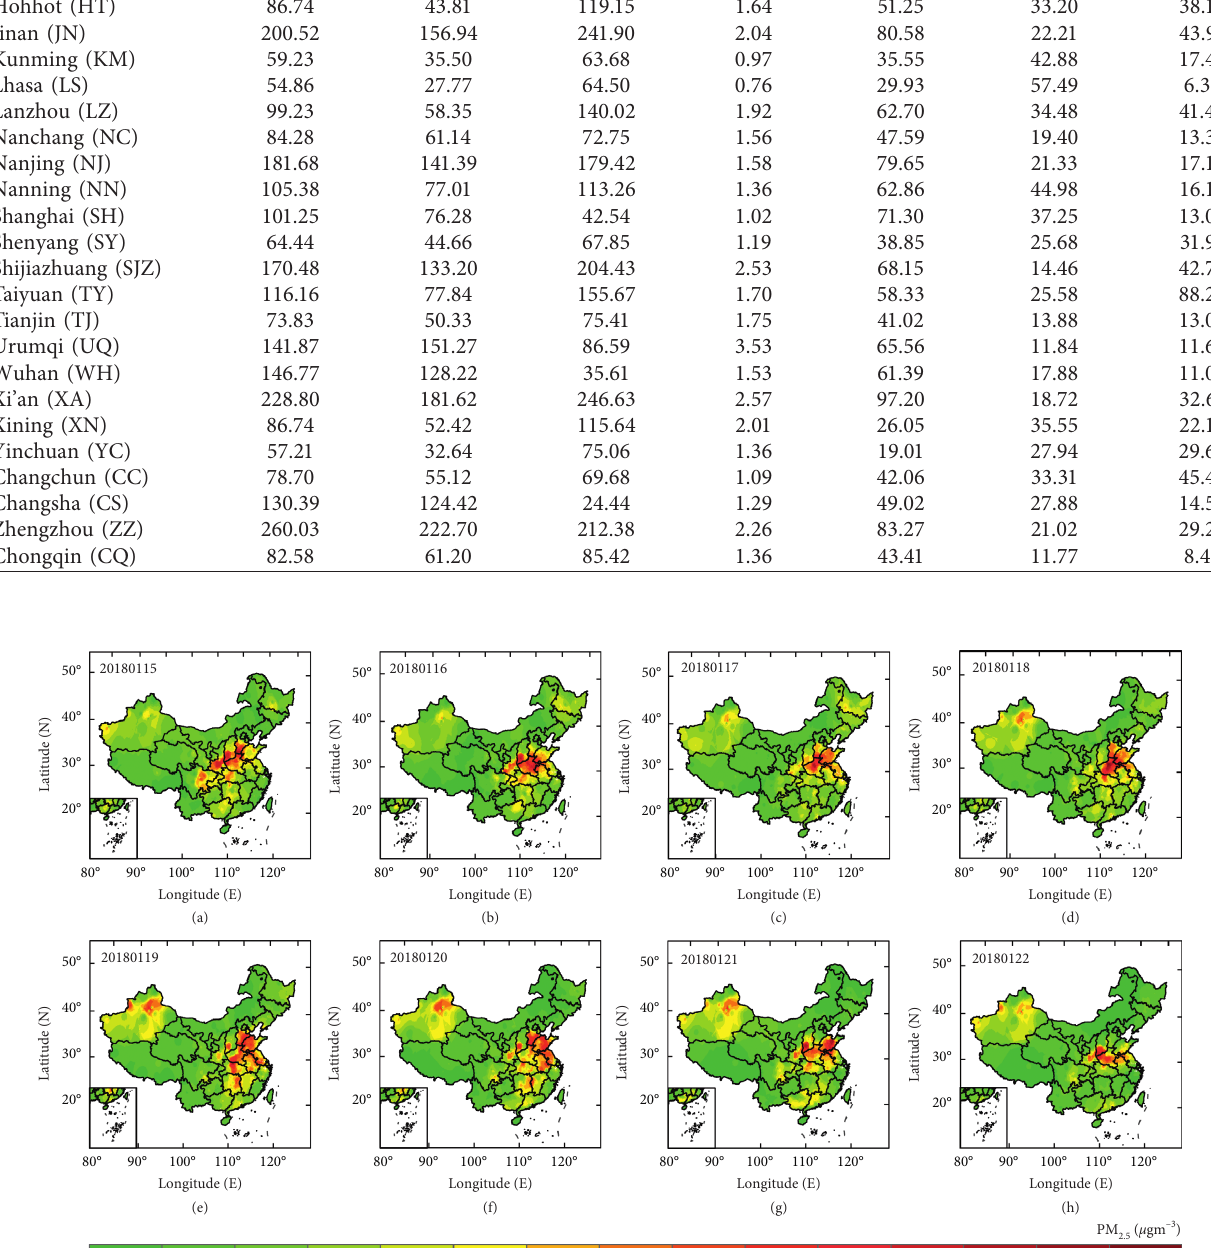
− 3) in 2.5 concentration ( μ g m